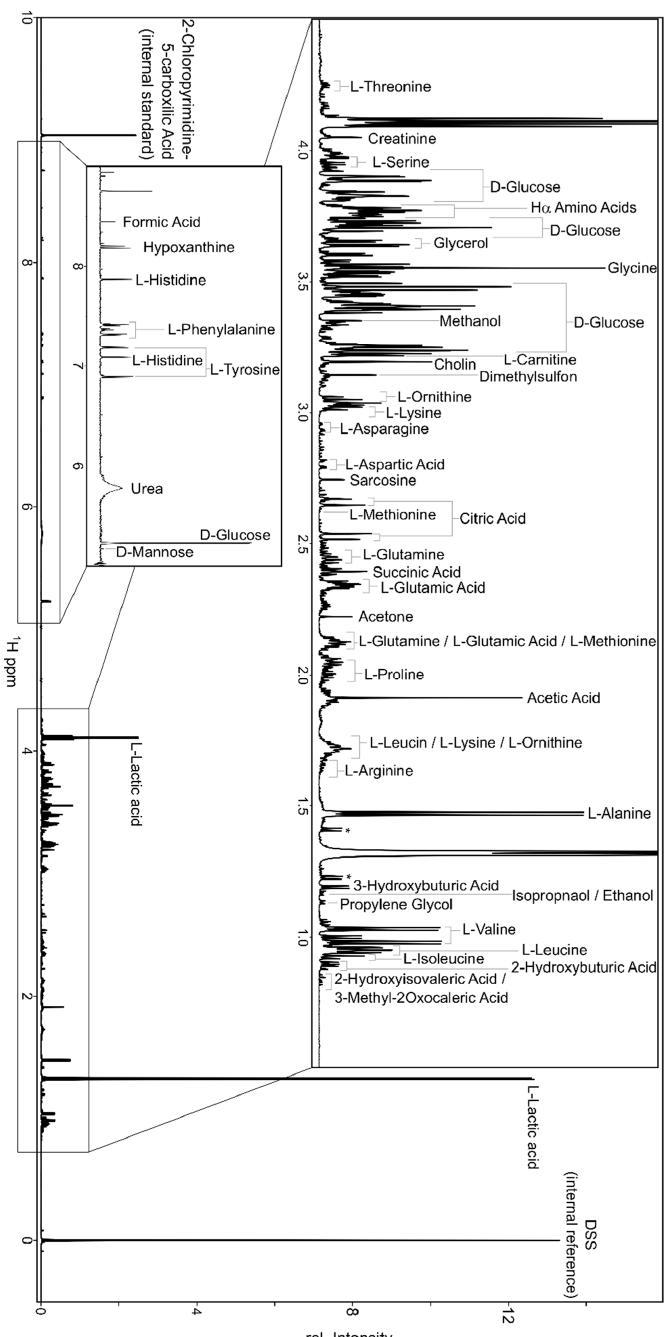
Figure 3. Annotated 1D 1 H NMR spectrum collected of NIST SRM-1950 human serum (ultrafiltered with a 3 kDa MW cutoff filter) at 700 MHz. The NIST SRM-1950 sample is a pooled human serum sample collected from a large number of volunteers and distributed by the National Institute of Standards. The identified compounds are labeled above each of the corresponding peaks. The high lactate peak is due the fact that the sample had not been metabolically quenched by NIST during its preparation, leading to the conversion of glucose to lactate.